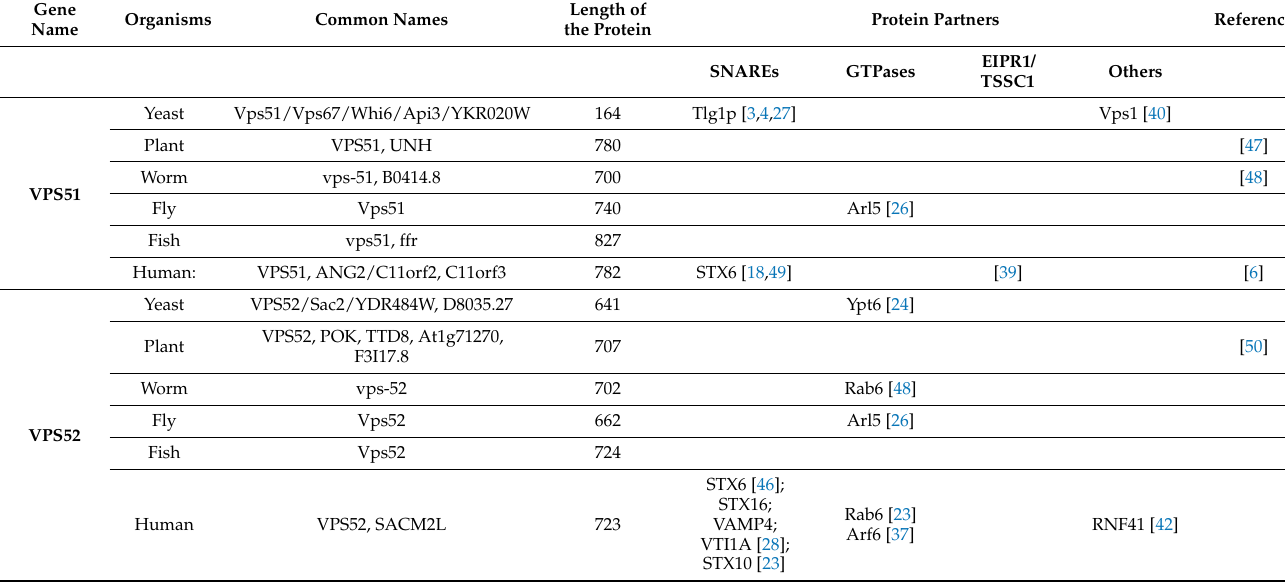
Table 1. GARP subunits and their proteins partners in different model